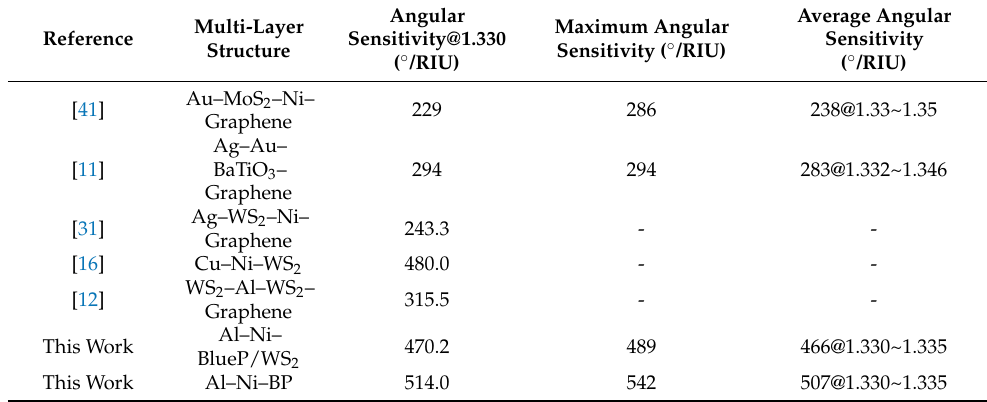
Figure 6. ( a ) Resonance angles corresponding to the different refractive index of sensing media for the SPR sensors with Al(40 nm)–Ni(22 nm)–BlueP/WS 2 (1 L) and Al(40 nm)–Ni(22 nm)–BP(1 L), ( b ) Sensitivity of SPR sensors under the refractive index of the sensing medium varying from 1.330–1.336 ( ∆ n = 0.001). Table 3. Angle sensitivity comparison of SPR sensors.